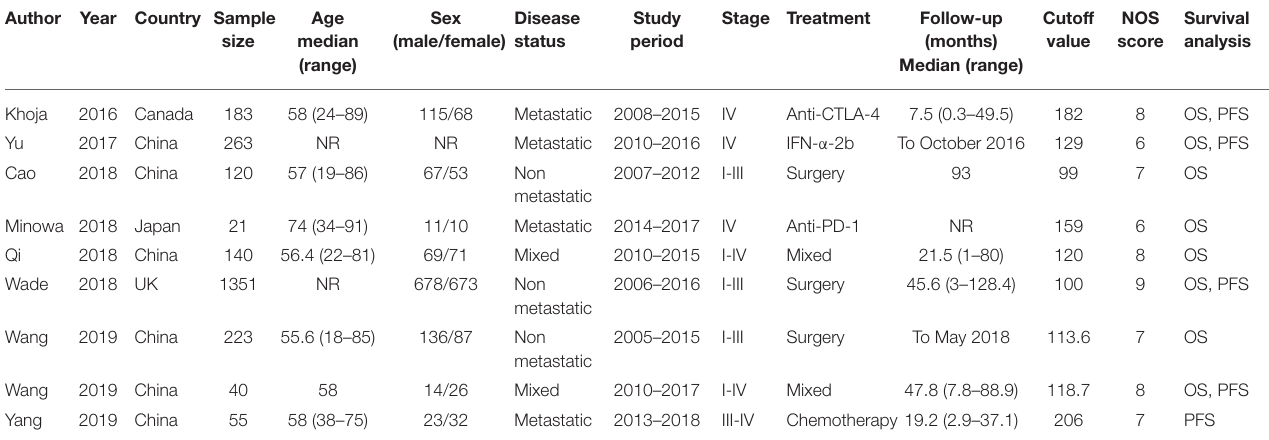
TABLE 1 | Characteristics of the included studies in this meta-analysis.